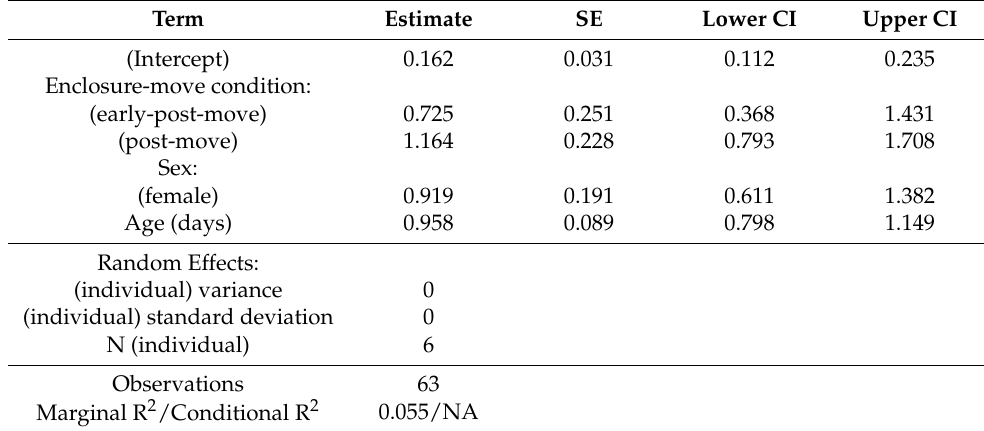
Table A10. Model 5 summary output: Effect of enclosure move on Sumatran orangutan visibility.